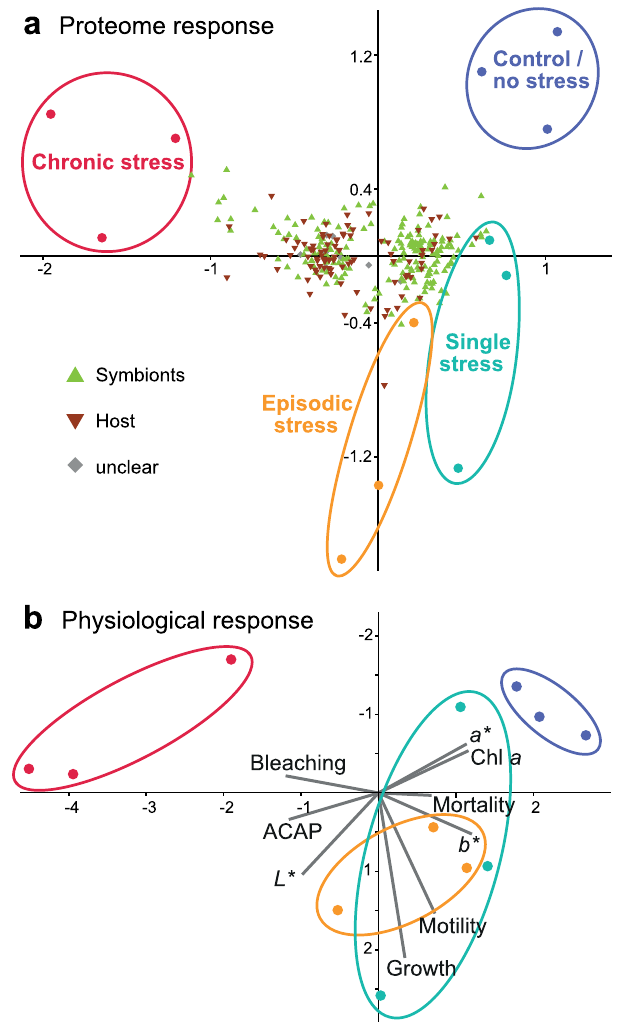
Figure 1. Comparison of proteomics results with the previously published physiological response of Amphistegina gibbosa in response to a single short-term temporary stress event (turquoise), episodic temporary stress events (orange) or chronic thermal stress (red) compared to the control treatment (blue). ( a ) Correspondence analysis of relative protein abundances of all 294 regulated proteins, showing the distribution of proteins (host = brown inverse triangles, symbiont = green triangles, unclear/both = grey diamonds) that drive the directional changes between treatments. 65.8% are explained by variation along axis 1 and 11.2% by axis 2. ( b ) Principal component analysis of physiological metrics of LBF from the same experiment 9 , including chlorophyll a concentration (Chl a ), total capacity against peroxyl radicals (ACAP), motility, growth rate, CIE L * a * b * colour space values ( L * = whiteness, a * = green to magenta, b * = blue to yellow), mortality and bleaching frequency. 60.1% are explained by variation along principal component 1 and 18.6% by principal component